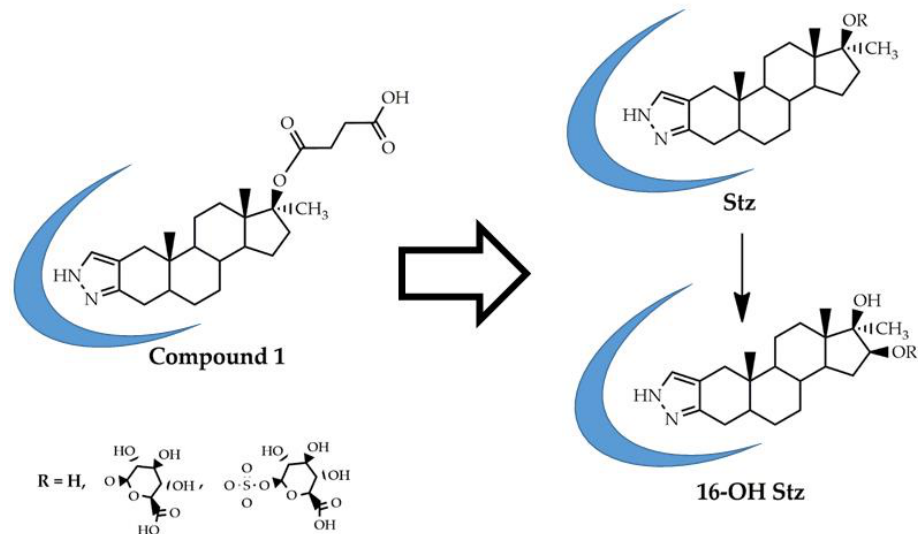
Figure 1. Chemical structures of compound 1 , Stz , 16-OH Stz , and their glucuronides derivatives. In light blue are indicated the expected recognition positions maintained in these chemical structures.